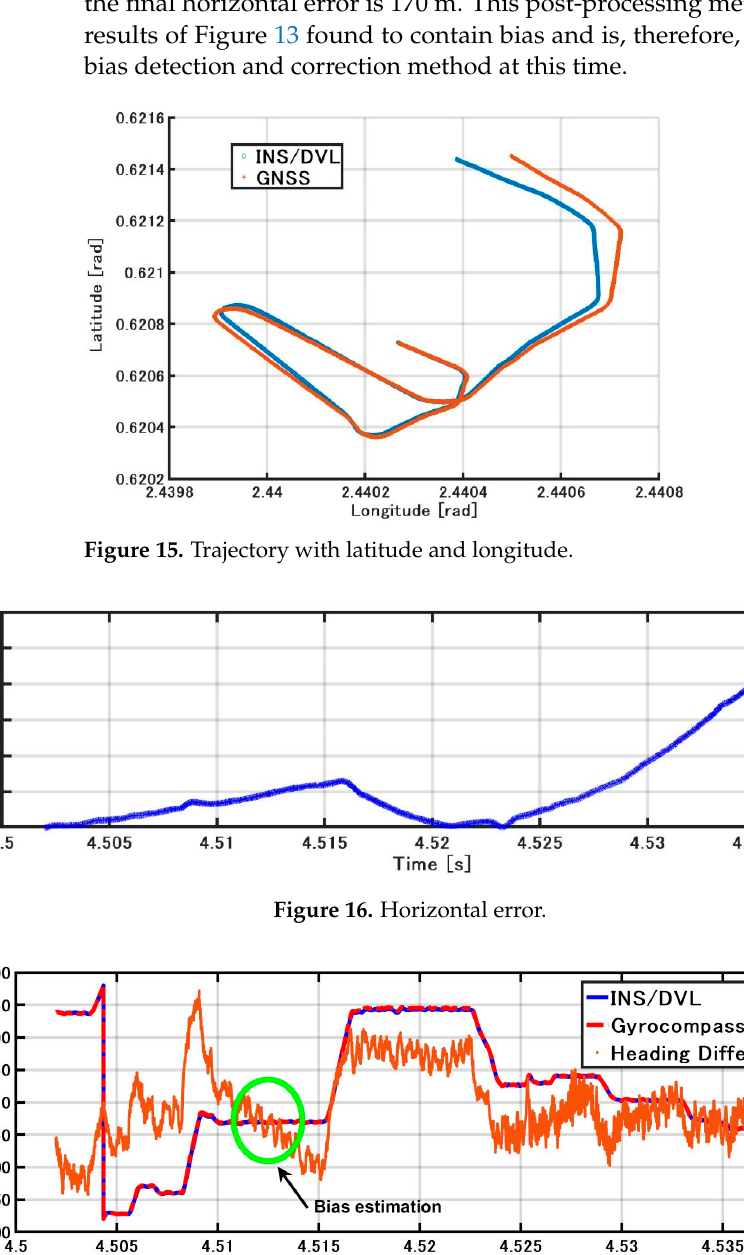
Figure 17. INS/DVL and gyrocompass heading angle and difference.